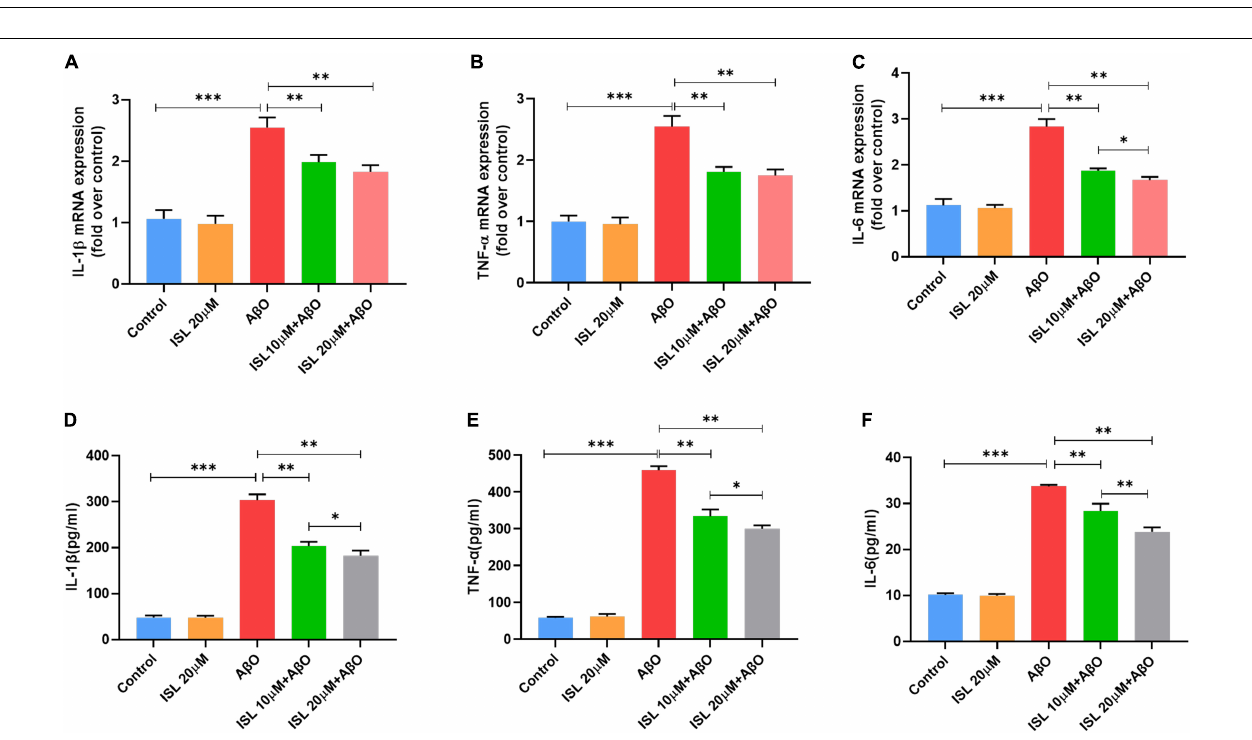
FIGURE 1 | The effects of Isoliquiritigenin on cell viability. (A) Cell viability of BV2 cells treated with ISL for 24 h was assessed by MTT assays. (B) Cell viability of N2a cells treated with ISL for 24 h was assessed by MTT assays. ns, not significant ( p > 0.05). n = 6 per group.